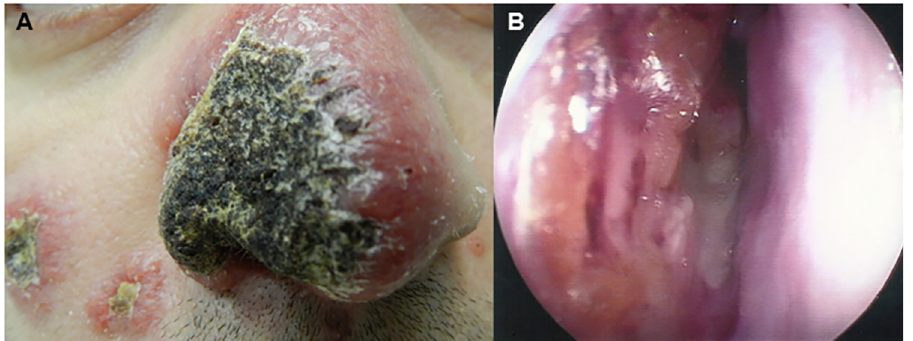
nasal mucosa. Source: Ana Cristina da Costa Martins (ENT outpatient clinic, INI/FIOCRUZ).